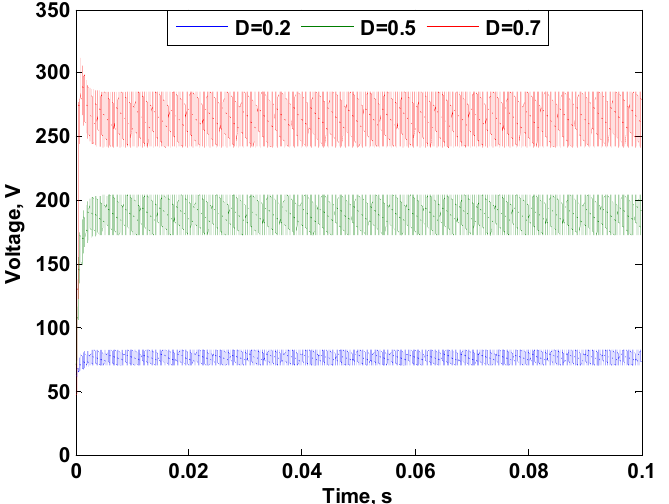
Figure 13. Output voltage at the output terminals of the studied converter when excited from three DC sources at different duty